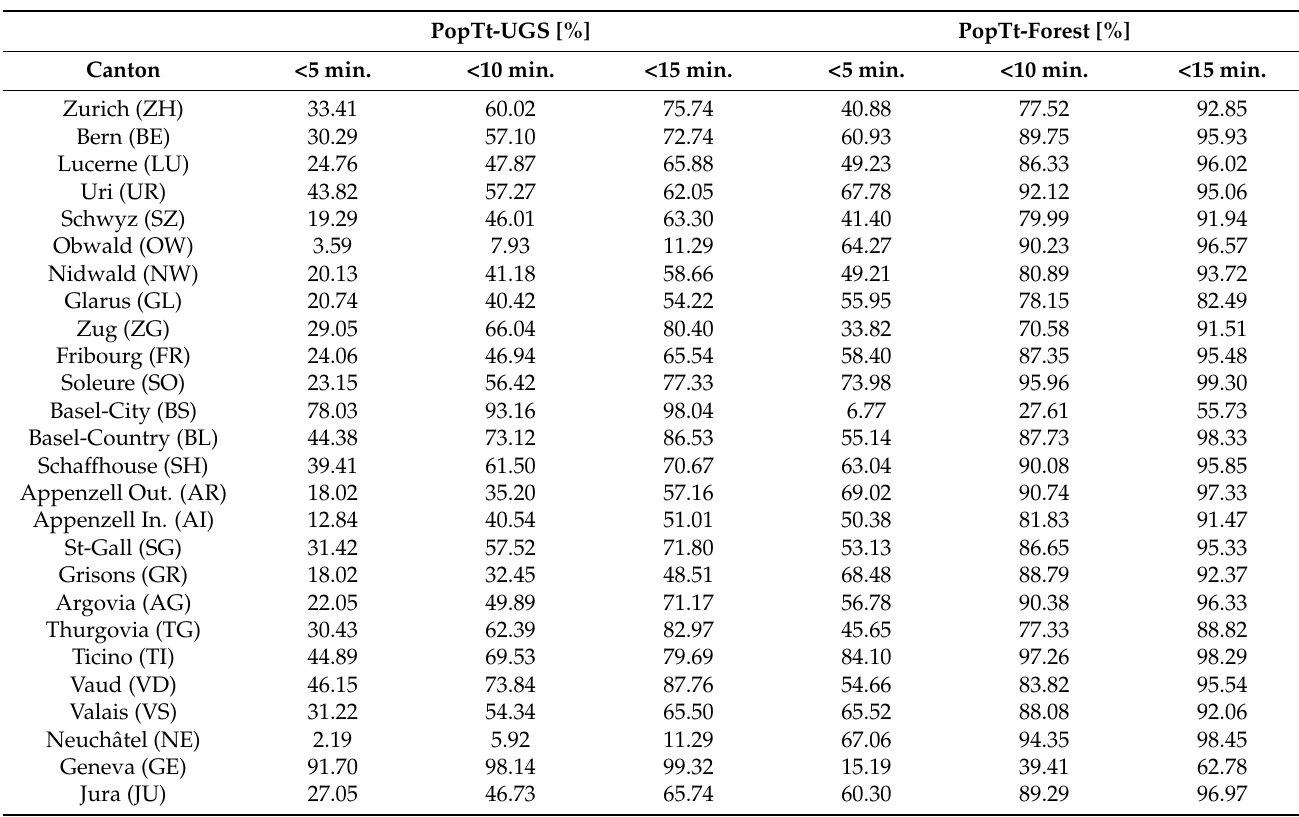
Table 4. Percentage of population that have access to a green space using their centroid and the anisotropic model (PopTt- UGS), and percentage of population that have access to a forest patch (PopTt-Forest) using the isotropic model, within a maximum travel time.